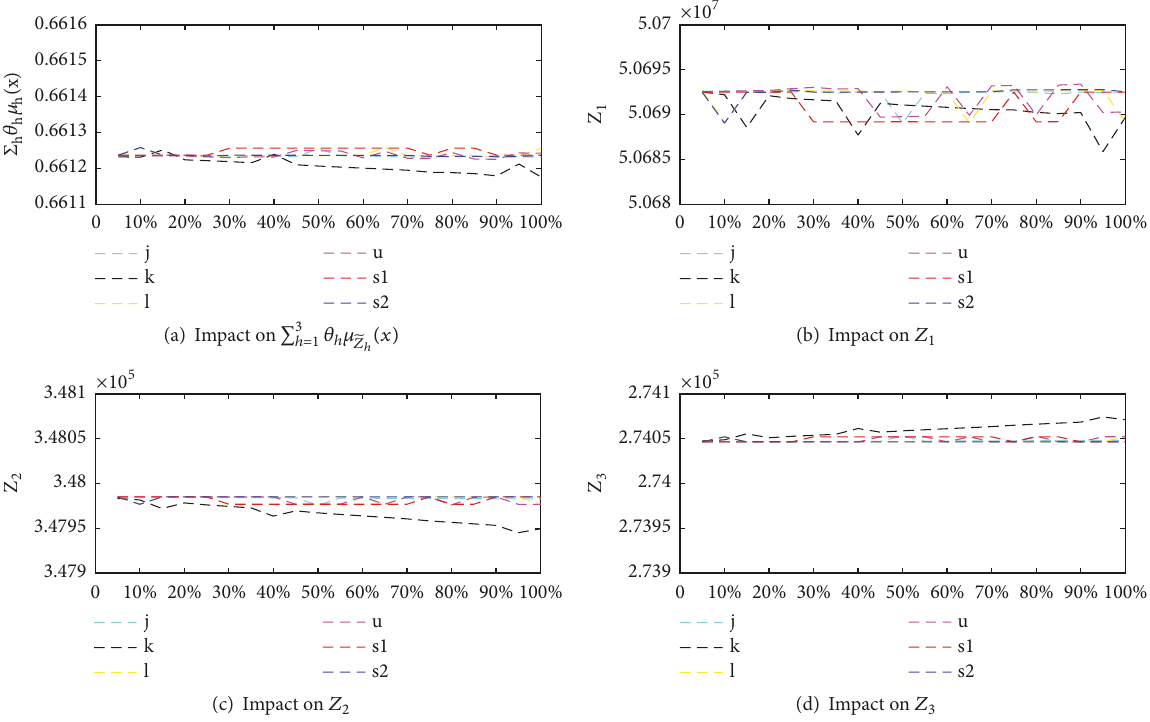
Figure 9: Sensitivity of standard